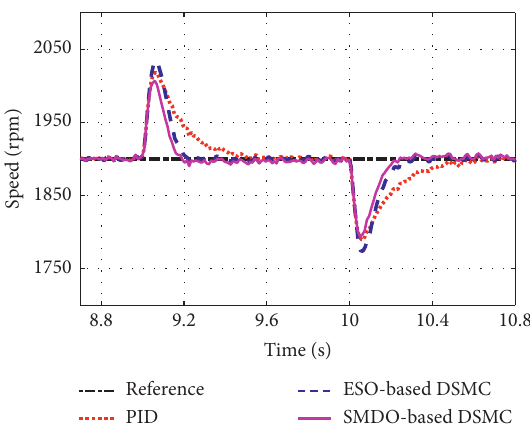
Figure 11: Diesel engine speed response during sudden loading and unloading.